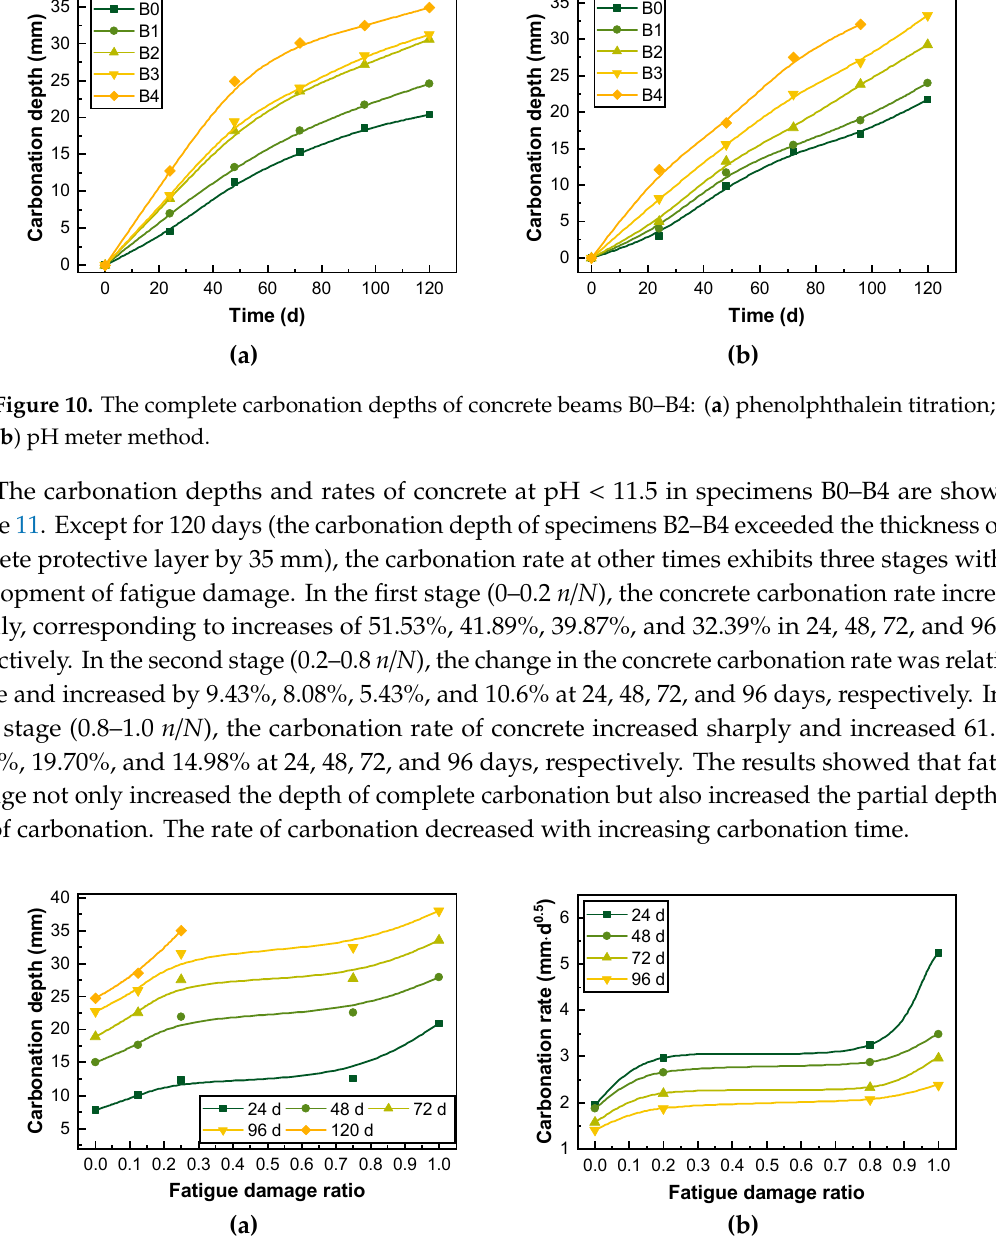
Figure 11. The carbonation depths and rates of concrete at pH ≤ 11.5 in specimens B0–B4: ( a ) carbonation depth and ( b ) carbonation rate.